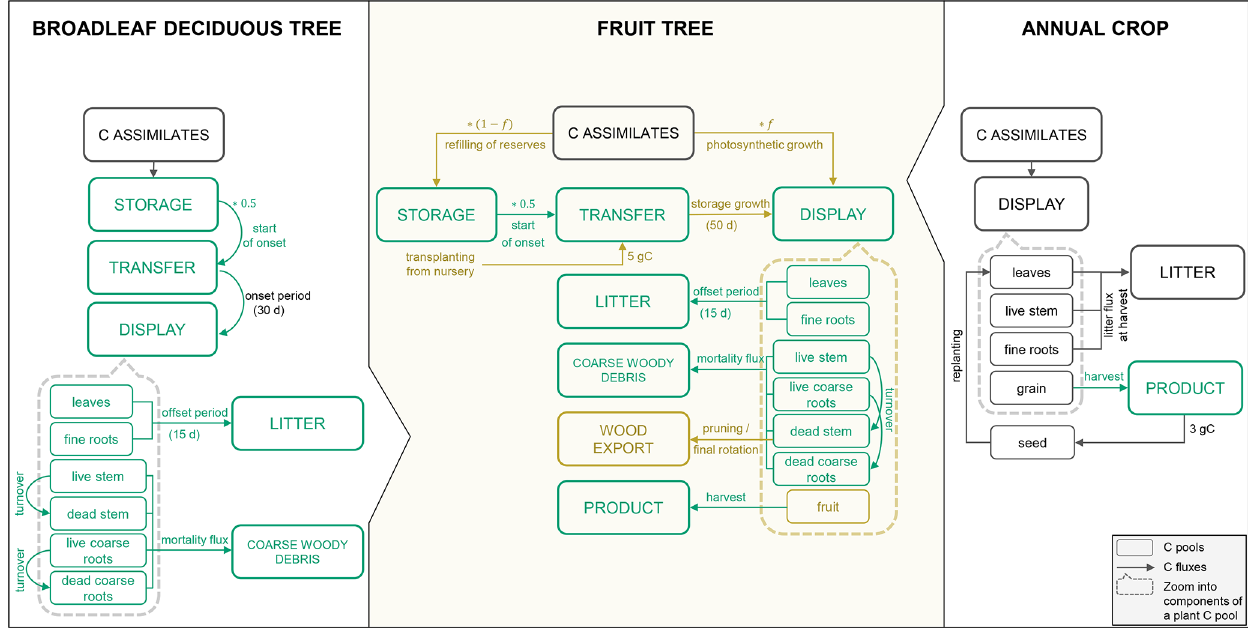
Figure 1. Schematic of the main phenology and C allocation features of the broadleaf deciduous tree and annual crop representations in CLM5 as well as the new CLM5-FruitTree sub-model. C pools within the dashed boxes are the individual components that make up the displayed C pool (the same components can be found for the other main plant pools: storage and transfer pools, respectively). Carbon pools and fluxes in green were reused for CLM5-FruitTree, while pools and fluxes in brown were modified or newly